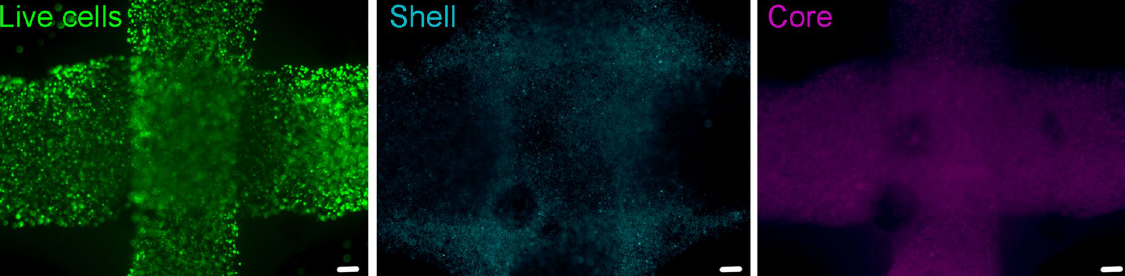
Figure 7. Core/Shell printing facilitates a layer by layer deposition of cell-laden hydrogels with structural integrity. Representative epifluorescent image of Calciein-AM (green channel) stained cells after 7 days from printing. The Shell and the Core has been differently labeled with fluorescent beads (cyan channel for Shell, violet channel for Core) to estimate the compartmentalization. An epifluorescent Olympus IX70 inverted microscope with a SPOT Diagnostic RT-Slider camera and SPOT Diagnostic software was used with an Olimpus 4X UPlanFL NA0.13 objective